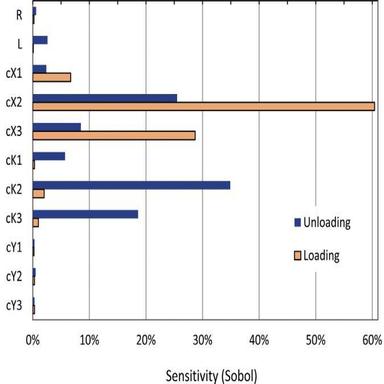
Sobol index for the loading and unloading measuring points from the sensitivity study of the present loading cycle. Coefficients cX1 to cX3 and cK1 to cK3 are defined in Eq. The coefficients cY1 to cY3 define Y(d) equivalent to Eq.